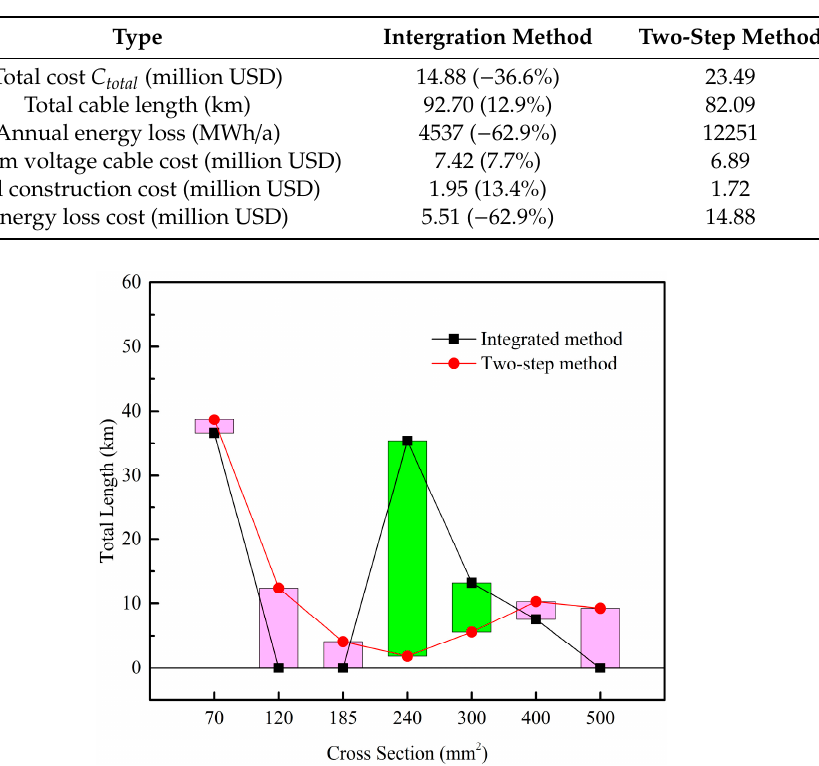
Table 2. Comparison of key economic parameters of the topology (references for the % are the values obtained by the two-step method).